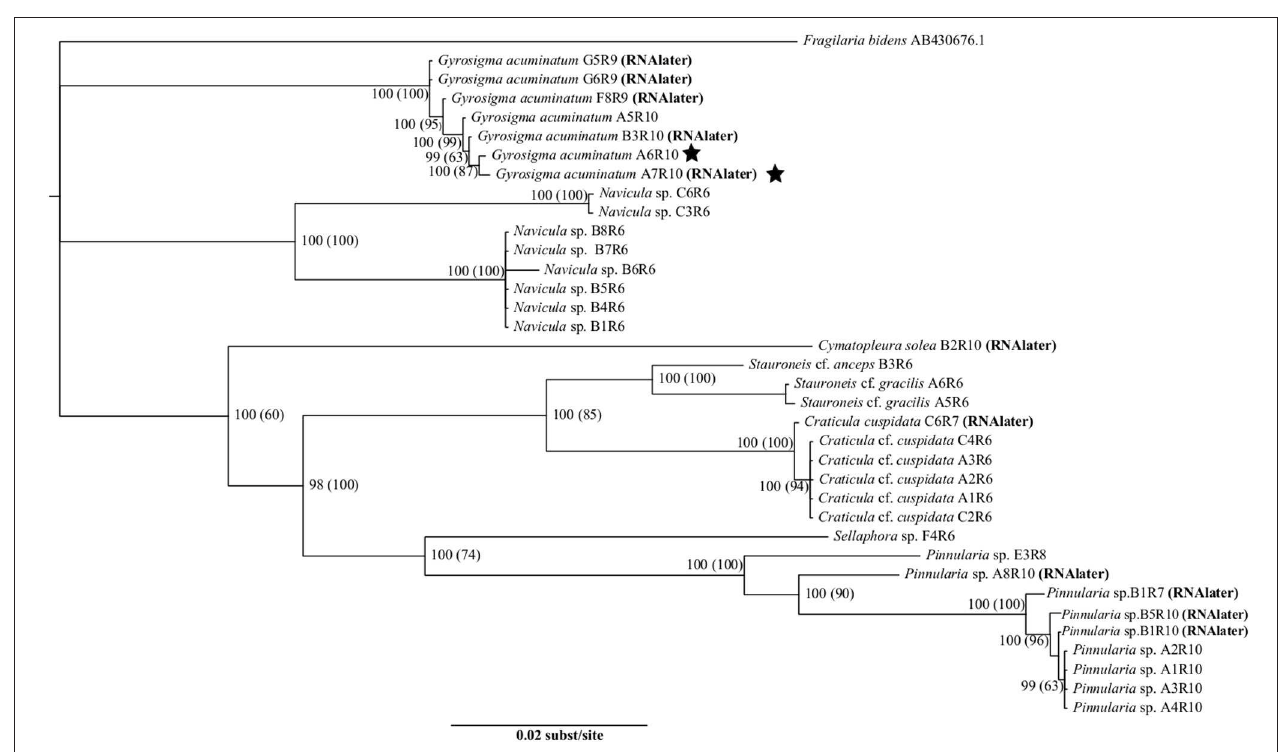
FIGURE 1 | Tree showing relationships of rbcL, 18S, and psbA using the best fit model, GTR + I + G. Statistical support is shown with numbers at nodes: Bayesian posterior probabilities (Maximum Likelihood bootstrap values). The stars indicates two Gyrosigma cells, one from a fresh sample and the other from an RNAlater preserved samples which had significantly similar sequences. Taxa are indicated to be from either RNA later or fresh